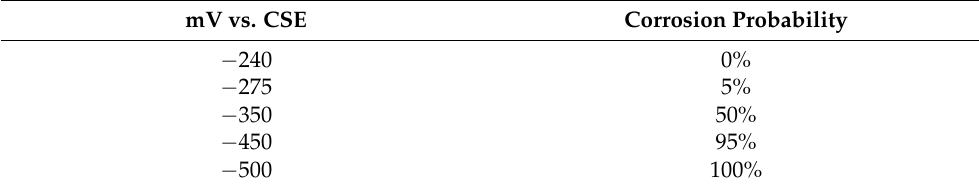
Table 7. Corrosion probability percentages for corrosion potentials with Stratful criteria [40,42].